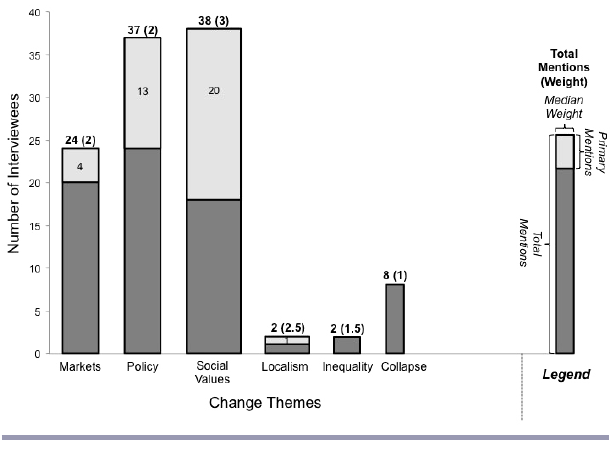
Fig. 4 . Summary statistics for each change theme from Yahara stakeholder interviews (n = 50). Each bar’s height represents total mentions by stakeholders, with primary mentions in lighter gray, and each bar’s width represents the theme’s median weight on a scale from 1 to 3.